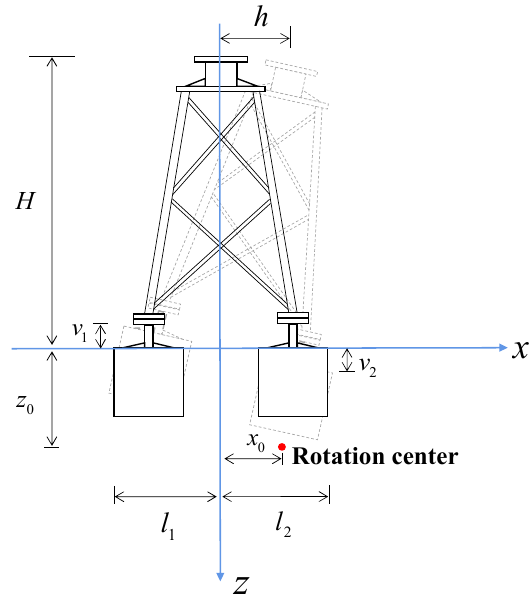
Figure 7. Coordinate system and parameters for determining the position of rotation center.